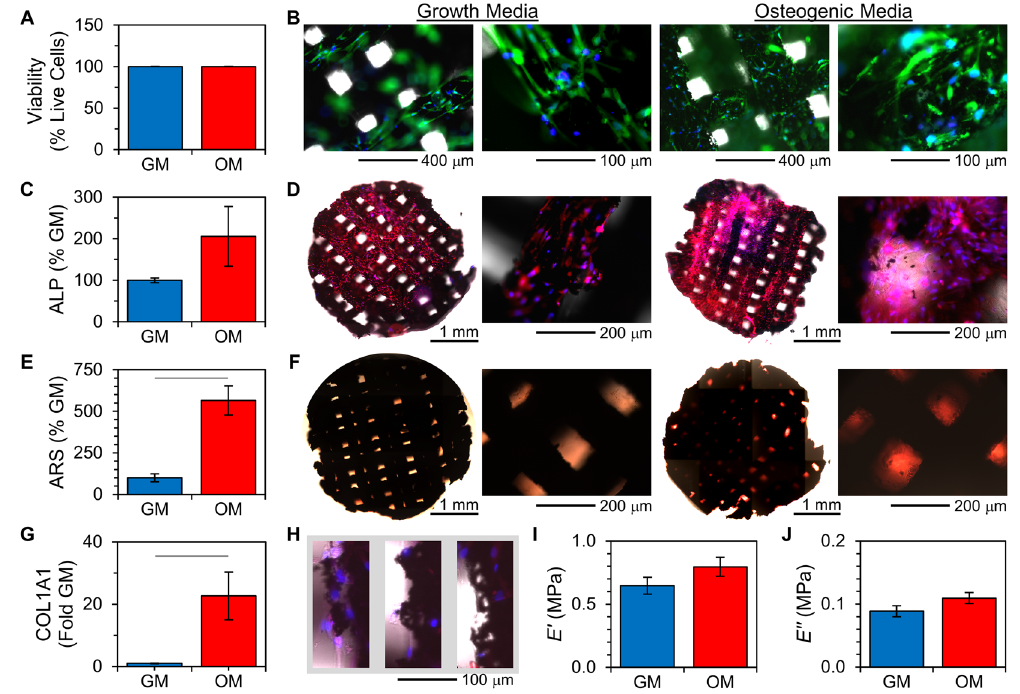
Figure 3. Compatibility and osteogenic differentiation of hMSCs on 3DP-CaPG matrices. (A) Percent cellular viability. n > 740 cells per condition; p -value = 1; error bars are standard deviation of sample proportion and are small (~ 0.1%). (B) Cytocompatibility images at different magnifications. Blue is all nuclei (Hoechst 33342); green is metabolically active cells (Calcein AM); and red is nuclei of dying cells (propidium iodide). (C) Alkaline phosphatase (ALP) expression, relative to that of hMSCs on matrices cultured in growth media (GM). n = 3 matrices; p-value = 0.22. (D) Whole-matrix and higher magnification images of fluorescently labeled ALP (red) and nuclei (blue). (E) Calcium deposit quantification using alizarin red S (ARS) labeling. n = 3 matrices; p-value = 0.007. (F) Color images of matrices labeled with ARS. (G) Relative gene expression of COL1A1 quantified from RT-qPCR. n = 3 samples from RNA pooled from cells cultured on 3 separate matrices per condition; p -value 0.03. (H) Images of struts of 3DP-CaPG matrices. Blue is nuclei; red is ALP; gray is brightfield. (I–J) Compressive dynamic mechanical analysis determination of the (I) storage ( E’ ) and (J) loss ( E’’ ) moduli of the matrices after 10 days of hMSC growth. n = 4 matrices; p -values = 0.21 and 0.17, respectively. Statistically significant differences are indicated by a line between data bars; unless otherwise indicated, error bars are standard error of the